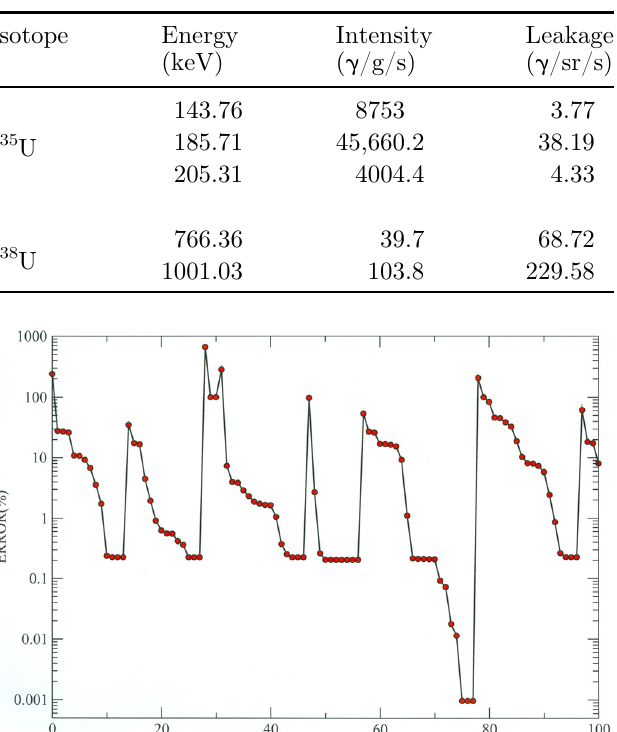
Table 3. g line characteristics and simulated leakage measurements.